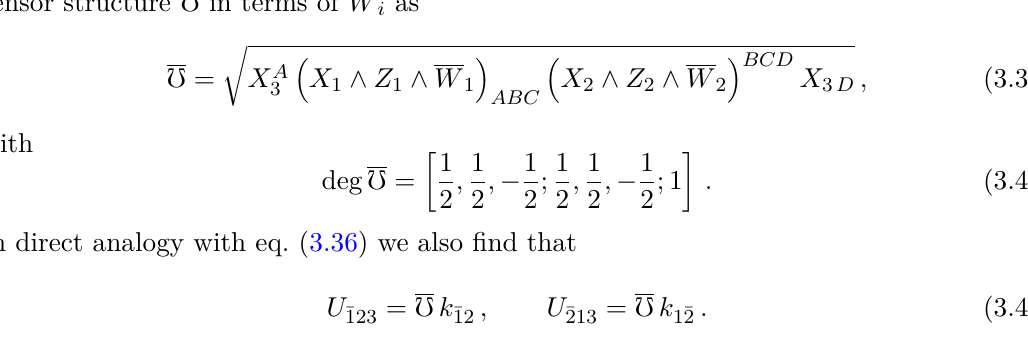
. Of course, it is also possible to construct a similar i i